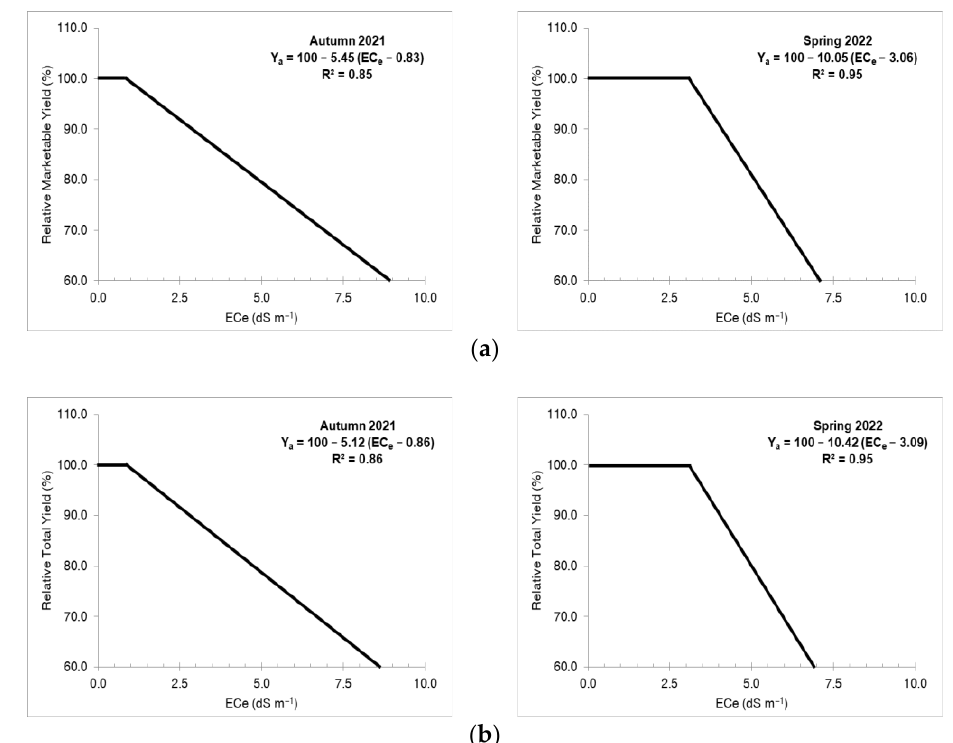
Figure 6. Salt tolerance models of tomato; ( a ) for marketable yield and ( b ) total yield.